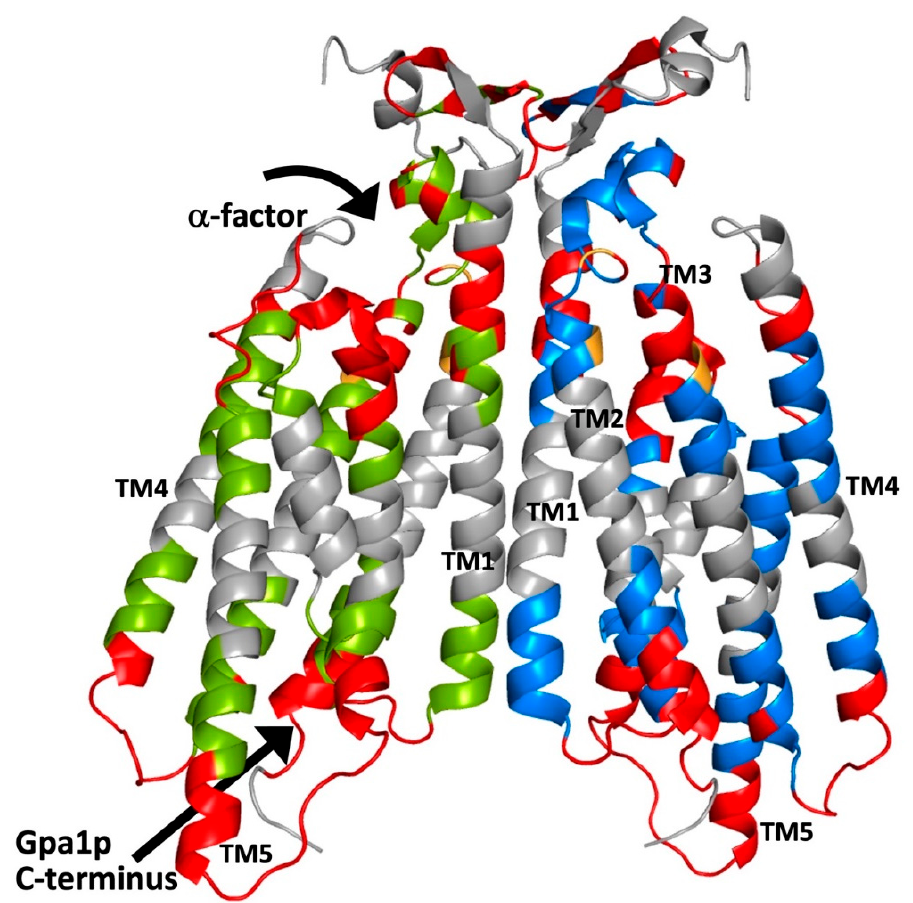
Figure 2. Amino acid positions in Ste2p that reside in transmembrane α -helical regions of the structure are accessible to labeling with MTSEA-biotin when mutated to cysteine. This figure shows the data from Figure 1 mapped onto the cartoon representation of the three-dimensional structure of the ligand-free Ste2p dimer (PDB code: 7QB9) [37]. Positions of residues that, when replaced by cysteine, were accessible to MTSEA-biotin are colored red. Positions that were tested but not accessible to MTSEA-biotin are colored green or blue for the two different Ste2p monomers. Positions that were not tested for cysteine accessibility are shown in grey. Positions for which there were discrepancies between publications are shown in orange. (All structural models presented in this manuscript were prepared using the PyMOL Molecular Graphics System (Schrödinger, LLC)).